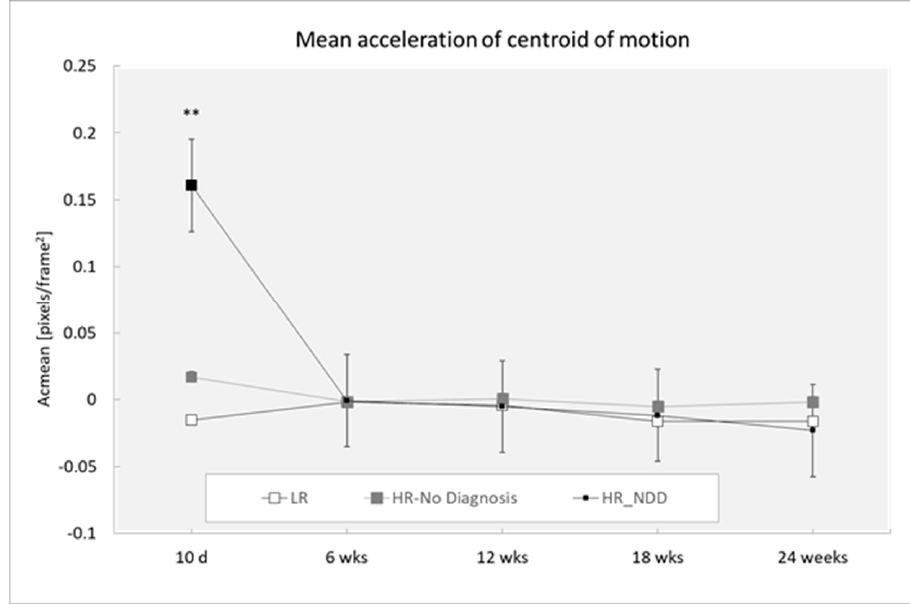
Figure 6. Mean acceleration of centroid of motion in a 3-min session, measured at 10 days and 6, 12, 18, and 24 weeks in three groups of infants (LR, n = 53; HR-no diagnosis, n = 32; HR-NDD infants, n = 18). d = days; wks = weeks. Data are expressed as mean ± SEM. ** p < 0.01 between HR-NDD and LR infants.